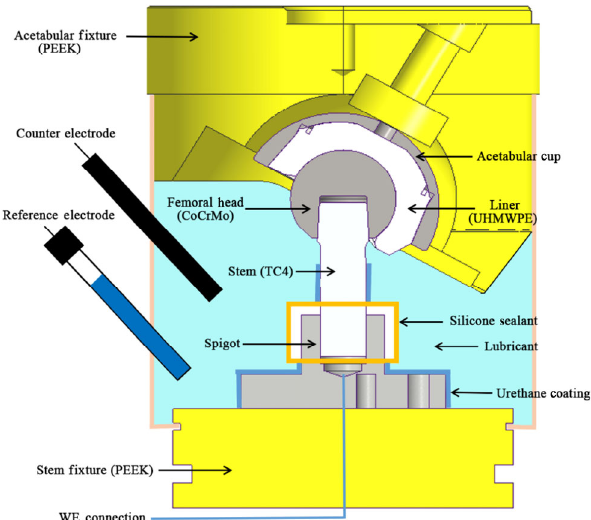
Fig. 1 Experimental setup demonstrating the working electrode (WE) connection to the stem and electrodes contained within the lubricant. Any possible metallic tribocorrosion sources were sealed via silicone sealant and urethane